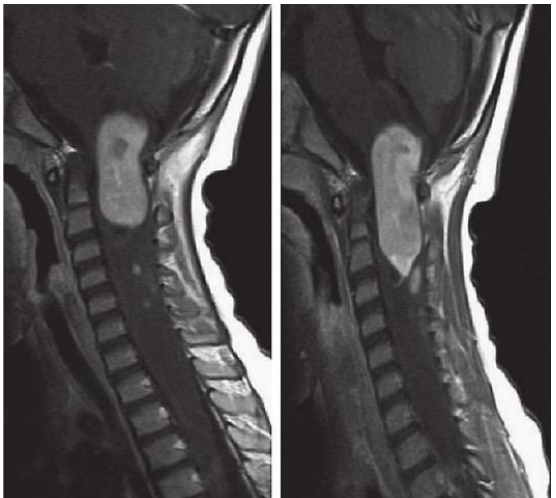
Figure 5 - Exophytic ganglioglioma (type III) bulbar - Contrast